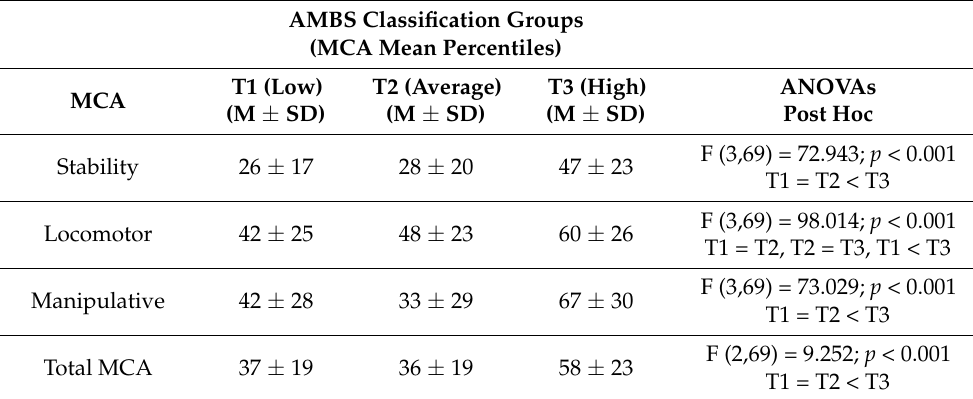
Table 3. Descriptive results for each MCA sub-scale and total, according to the AMBS group classi- fication, and ANOVAs and post hoc tests.